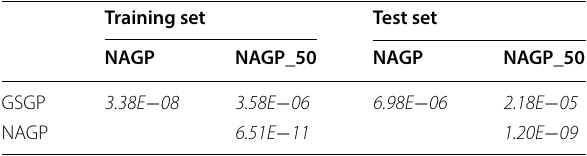
Italics denotes statistically significant